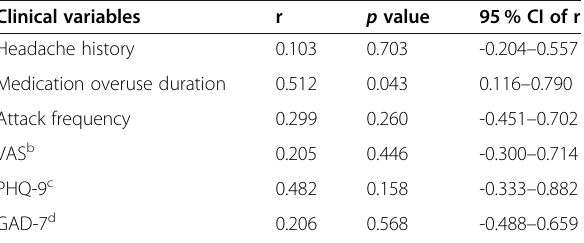
Table 3 Correlation analysis between functional connectivity of habenula-SN and clinical variables of MOH + CM a subjects Clinical